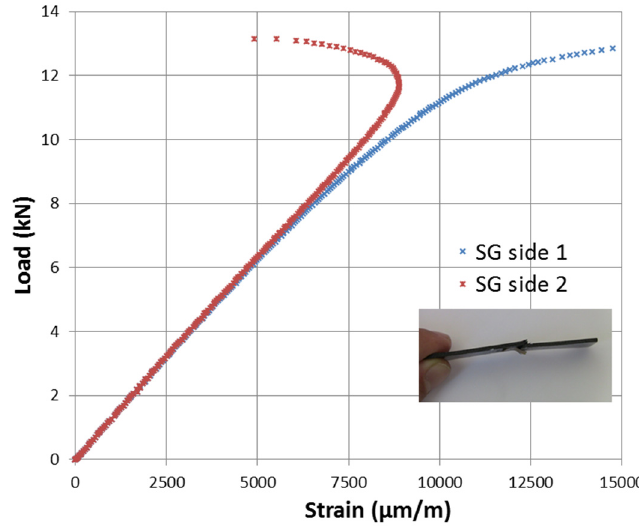
Figure 5. Compression test for weft-directional laminate: typical measured load vs. longitudinal strain data and typical failure mode.